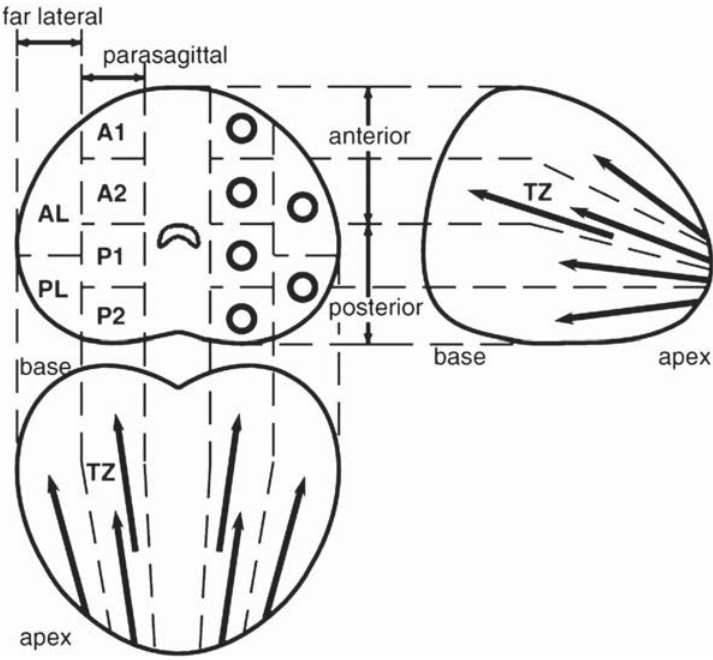
Figure 2 - 14-core scheme, as described by Kawakami et